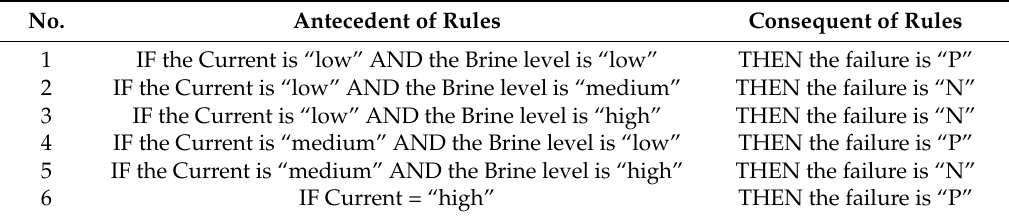
Table 9. Classification rules for brine pump failure.